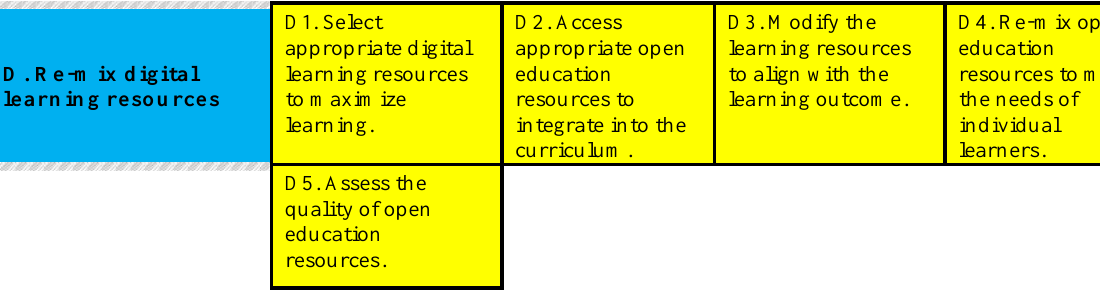
Figure 6. Re-mix digital learning resources competencies for the digital teacher.